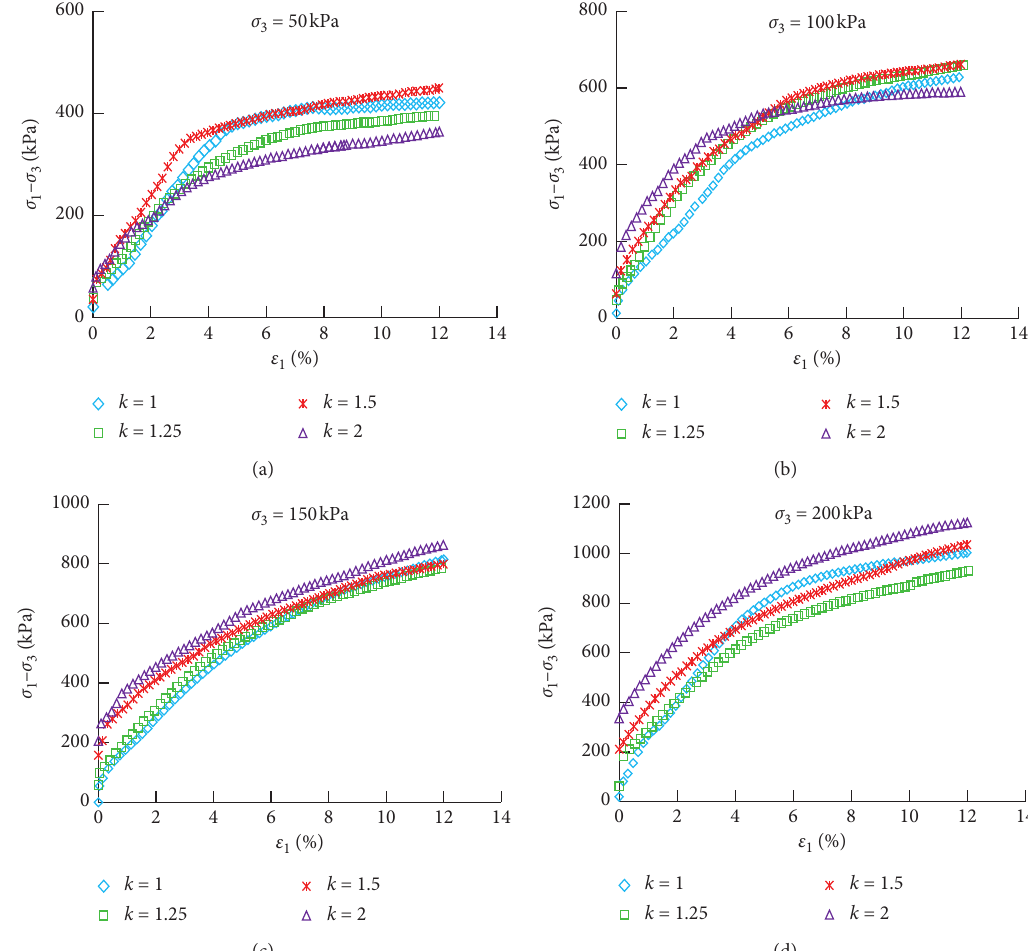
Figure 4: Stress-strain curves of intact loess at different confining